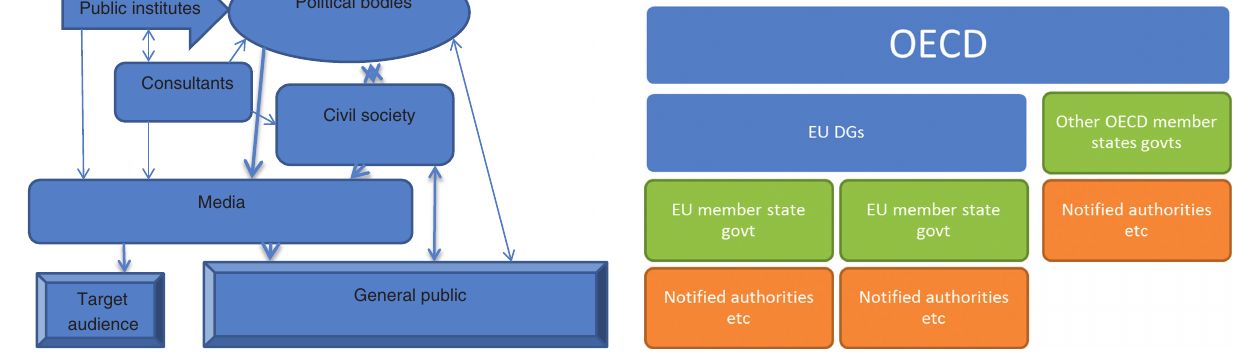
Figure 2 The nano-dialogue and communication “ecosystem”. Figure 3 The nano-regulation